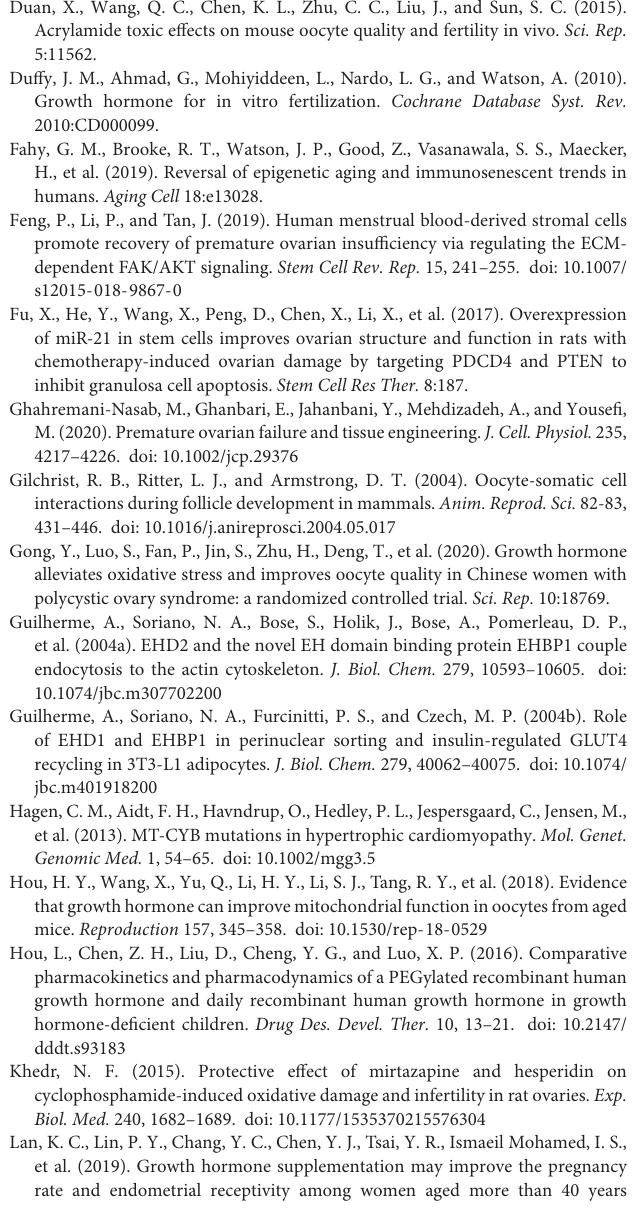
Supplementary Figure 1 | Daily records of the estrous cycle. (A) Representative pictures of different stages of the estrous cycle: proestrus (P) (a) , estrus (E) (b) ,